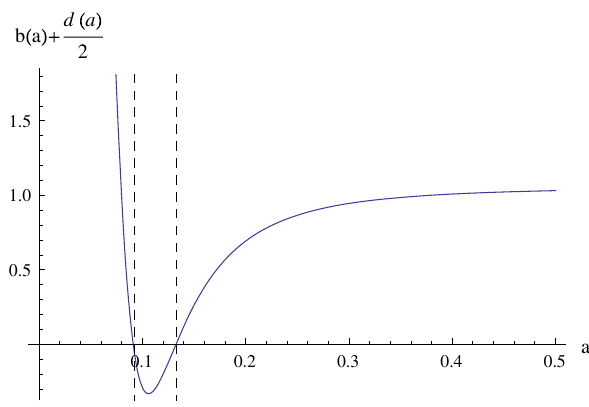
Fig. 5 The evolution of b ( a ) + d ( a ) . For values of the scale factor for 2 = 0 has roots, the freeze singularities which the equation b ( a ) + d ( a ) 2 appear ( black dashed lines). This figure corresponds with Fig. 4 two freeze singularities appear. This situation is presented in ˆ ˆ ˆ ˆ R 2 − 10 − 6 R 3 . In this case they R ) = R + 10 − 2 Fig. 4 for f ( appear two freeze singularities and one sudden singularity.